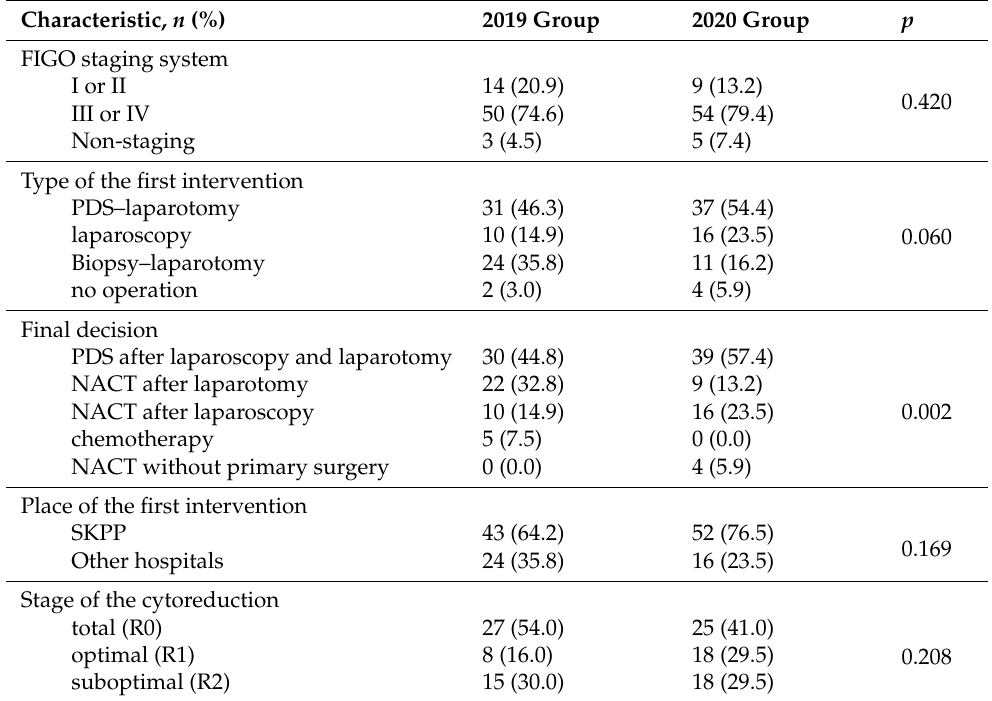
FIGO—the International Federation of Gynaecology and Obstetrics; PDS—primary debulking surgery; NACT—neoadjuvant chemotherapy; p — p -value. Dependencies between the group and selected characteris- tics were analysed using the chi-square test with Yates’ correction for continuity for two categorical